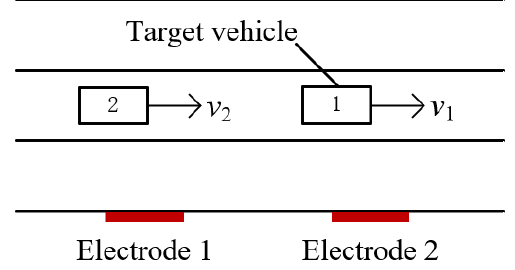
Figure 14. Diagram of vehicles driving close together.